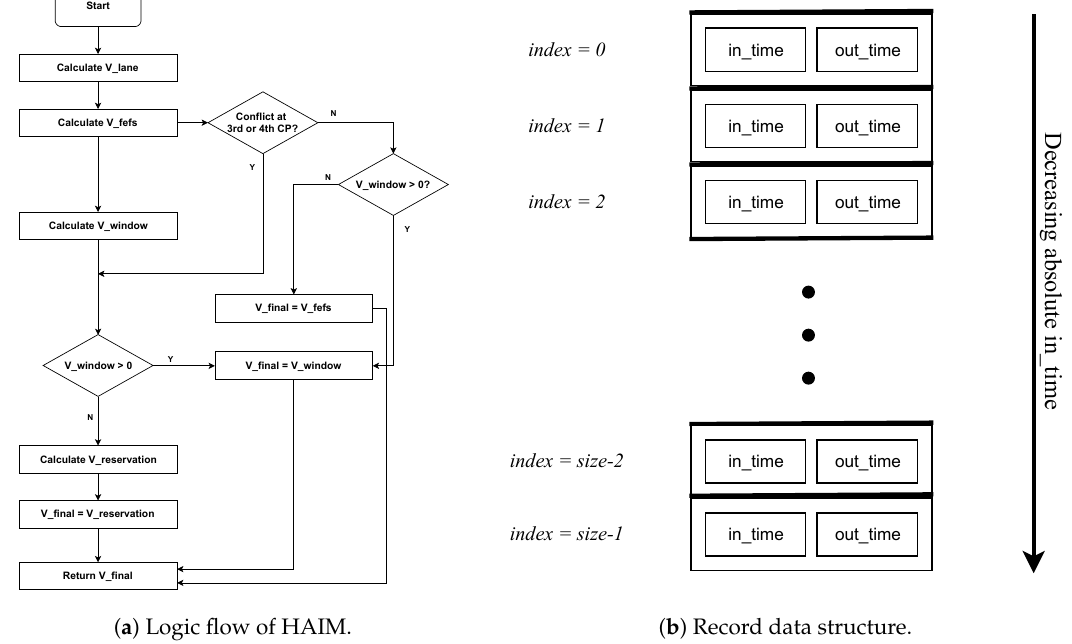
Figure 3. Heuristic Autonomous Intersection Management (HAIM) logic diagram and Record data